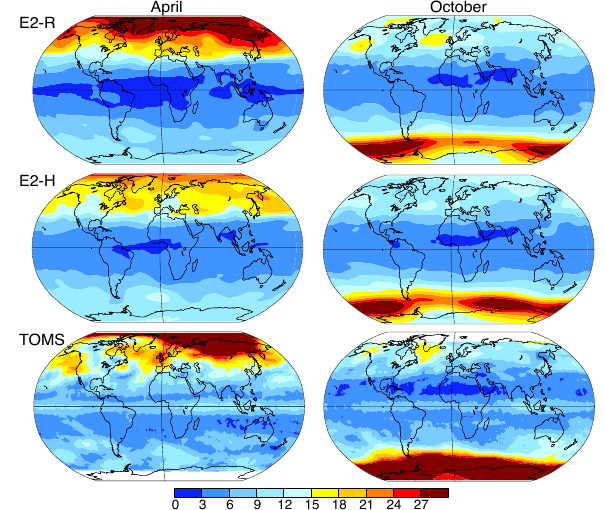
Fig. 13. Standard deviation of total column ozone (DU) in April (left) and October (right) in the E2-R (top row), E2-H (2nd row) and TOMS observations (bottom row). Models are 2000–2009, while TOMS data is from